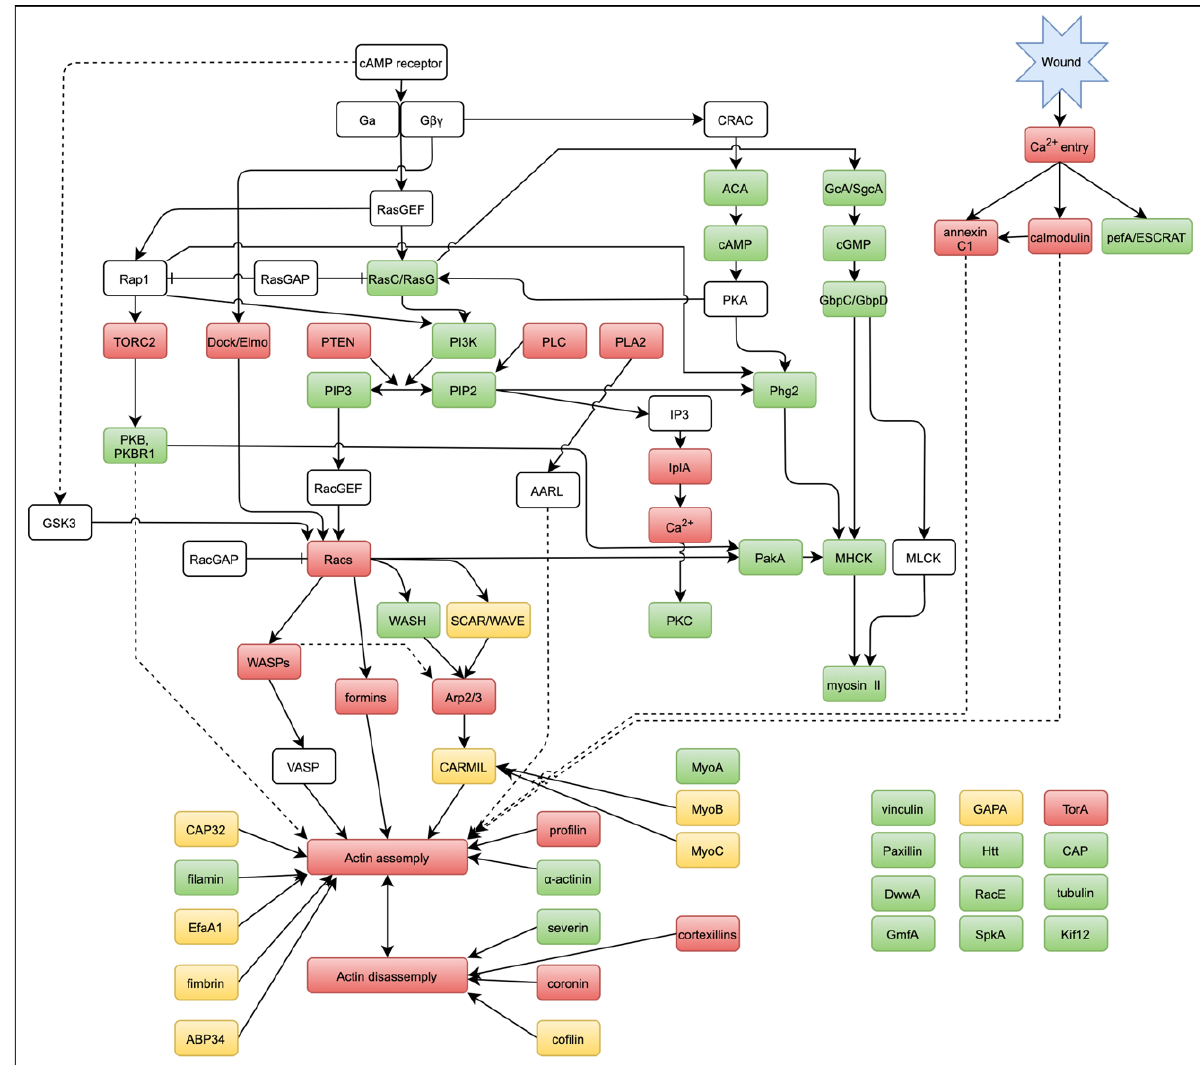
Figure 6. Signal pathways for actin dynamics in wound repair. With reference to the signal cascades for chemotaxis, potent candidates for wound-related signals, ARPs, or other proteins we found in the present and previous studies are marked (red). Some proteins (yellow) accumulate or disappear at the wound site, but their contribution remains to be clarified using knockout or inhibitor experiments. Most of the examined proteins (green) do not contribute to wound repair.